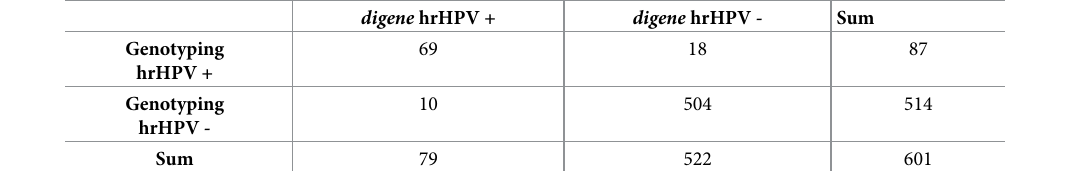
Table 2. Comparison of the vaginal health assay for the detection of genotyped hrHPV in DNA extracted from 601 vaginal samples to that of the digene HC2 hrHPV assay. The genotyping assay was considered positive if